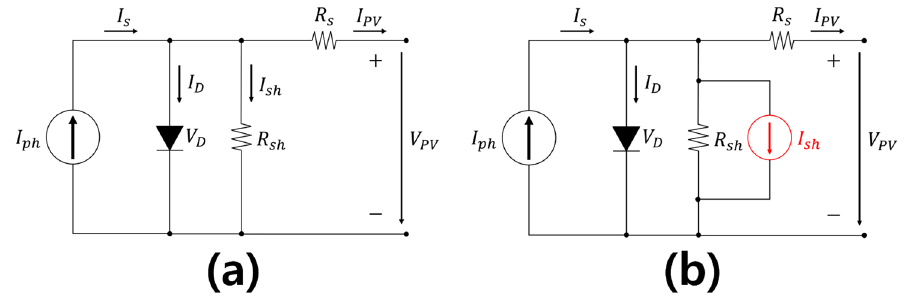
Figure 2. Forward and reverse biases occurring in equivalent circuits in PV modules with bypass diodes. ( a ) An equivalent circuit in the normal power generation of a photovoltaic module protected by a bypass diode; ( b ) a circuit where a reverse current occurs if the resistance increases